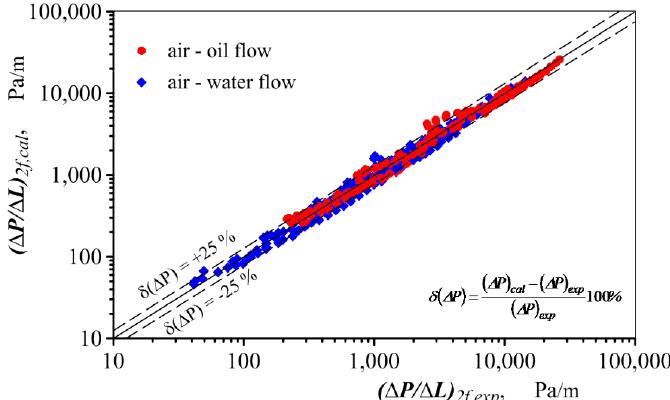
Figure 19. Comparison between the measured pressure drops in the gas–liquid flow ( Δ P/ Δ L) 2f , sxp and pressure drops ( Δ P/ Δ L) 2f , cal calculated from the Equation (12).